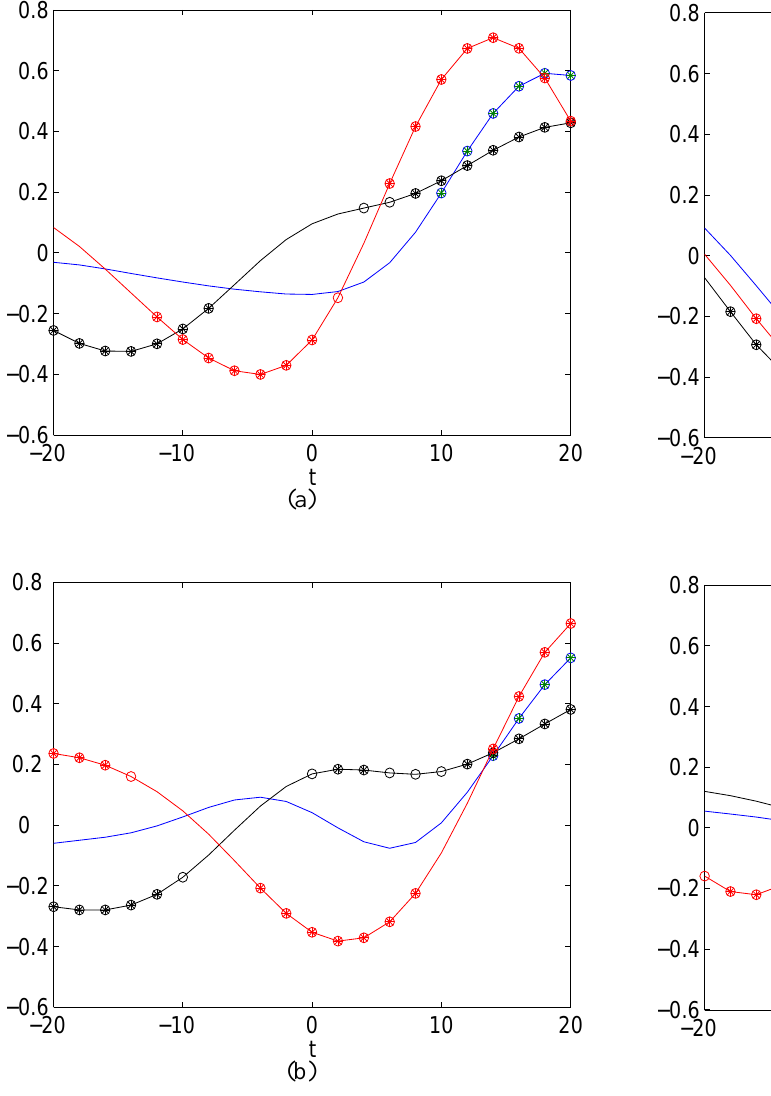
Fig. 14. Correlations of mixing rates for the BL inflow box (a) and eyewall updraft box (b) lagged by t to maximal tangential winds with 20 min. backward integration time for FMR (red), FRD (black), and MMR (blue). Filled circles indicate correlation above a 99% confidence threshold, while open circles indicate correlations above 95% but below 99% confidence.